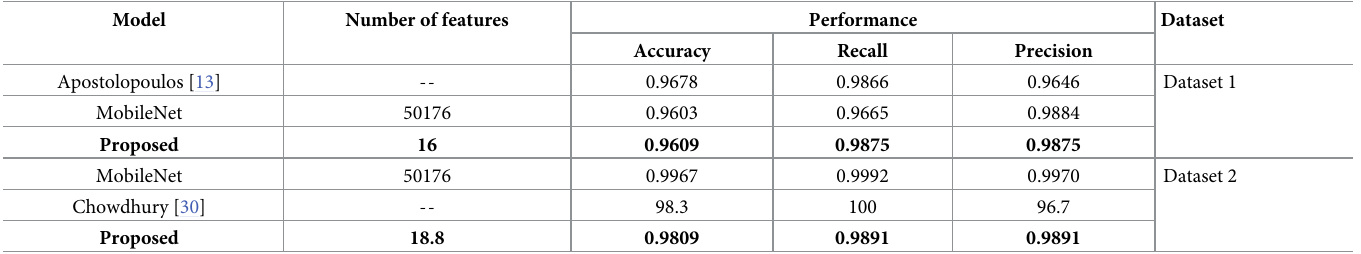
Table 5. Comparison with MobileNet and related works. Model